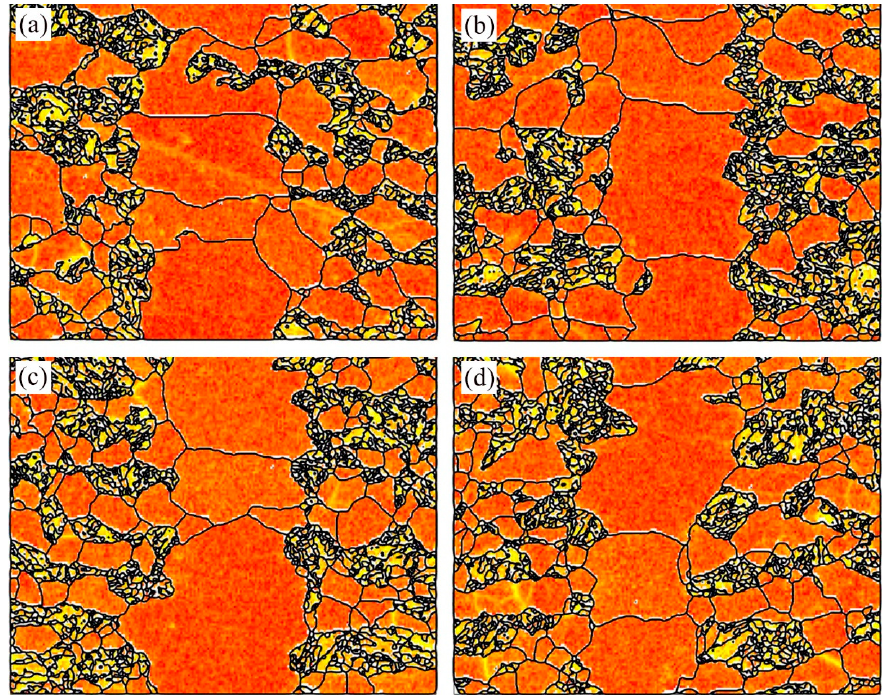
Figure 16. GND maps of the joint regions for different aging times: ( a ) 5 h, ( b ) 20 h, ( c ) 100 h, and ( d ) 500 h.